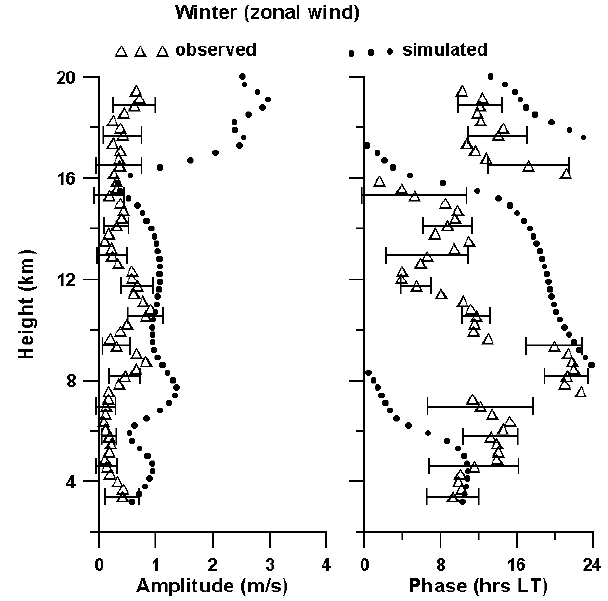
Fig. 5. Same as Fig. 3, but for the winter